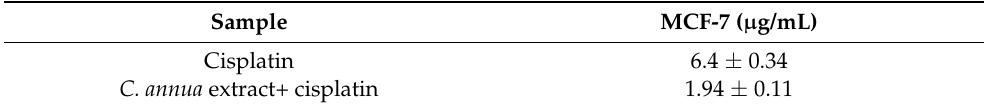
Table 3. IC 50 values of cisplatin and C. annua extract–cisplatin as adjuvant therapy against breast MCF-7 cells using the MTT